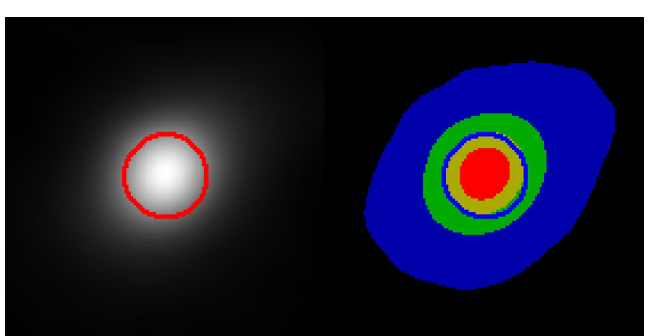
Figure 7. Output from the prototype software showing an image of the focal spot. Left: Monochrome image with a 10 µm red circle for scale. Right: Colour image where red is 75–100% peak, yellow 50–75%, green 25–50% and blue 5–25%, with blue 10 µm diameter blue